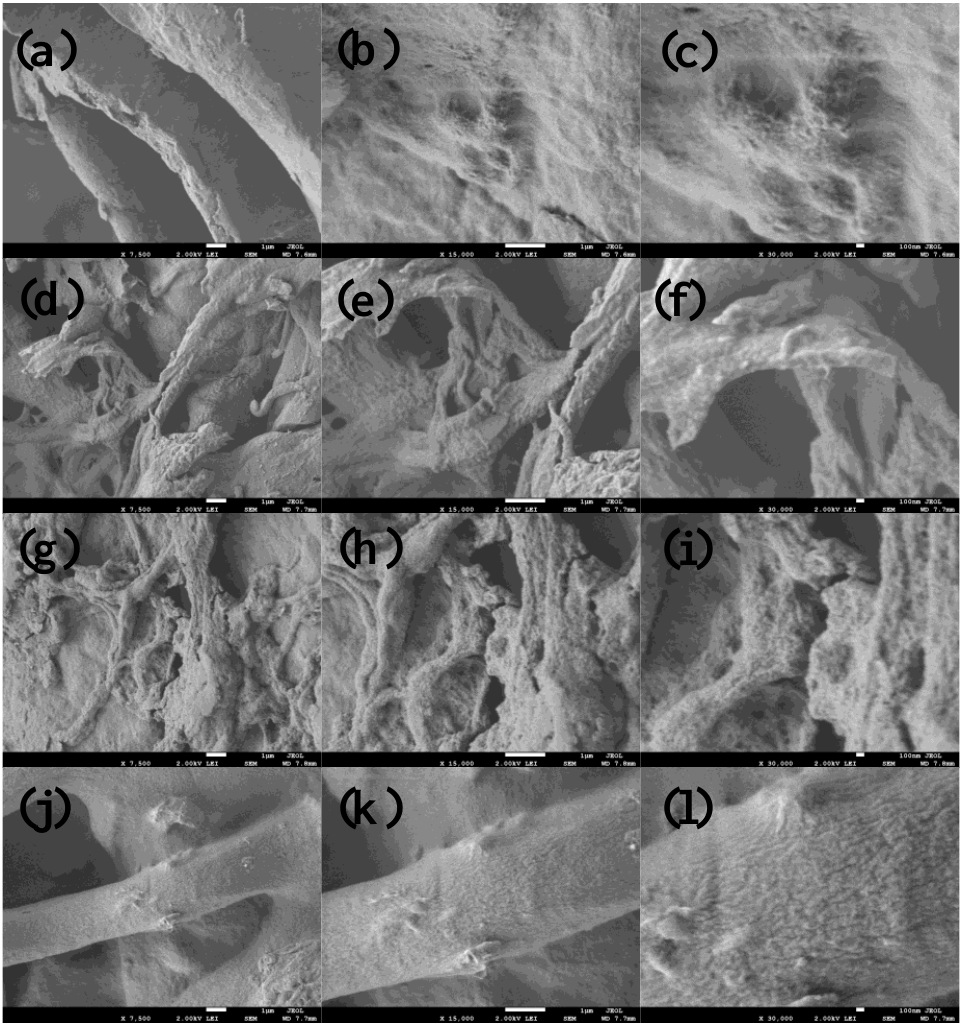
Figure 2. SEM images of CA ( a – c ), Ni 3 S 4 /CA ( d – f ), Ag 2 S/CA ( g – i ) and Ni 3 S 4 /Ag 2 S/TiO 2 /CA ( j – l ) at different